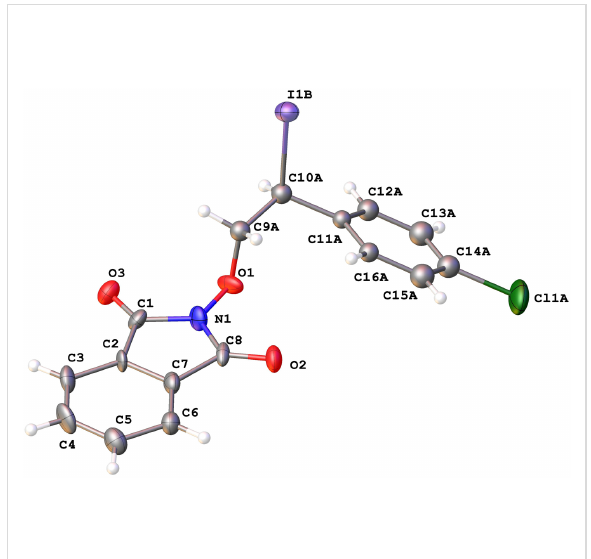
Figure 2: Molecular structure of 3ca . Atoms are presented as anisotropic displacement parameters (ADP) ellipsoids (50% probabili- ty). For clarity, only one set of positions of the disordered ethylene bridge and Ph groups is